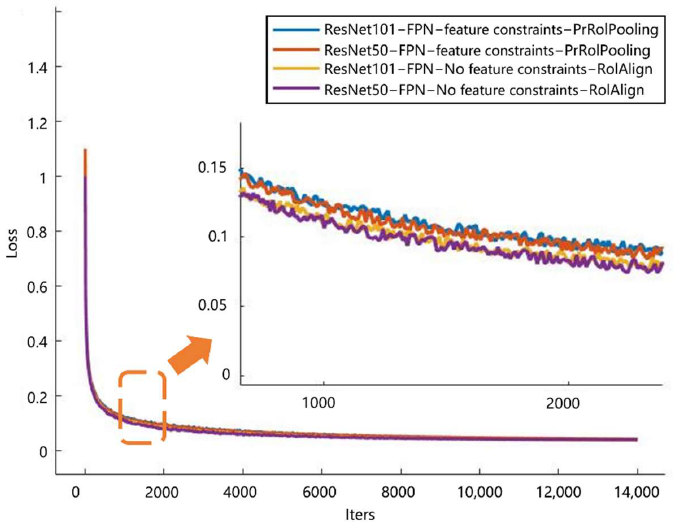
Figure 7 [M14][wk15] . Iterative loss curves for different models. Figure 7. Iterative loss curves for different models.